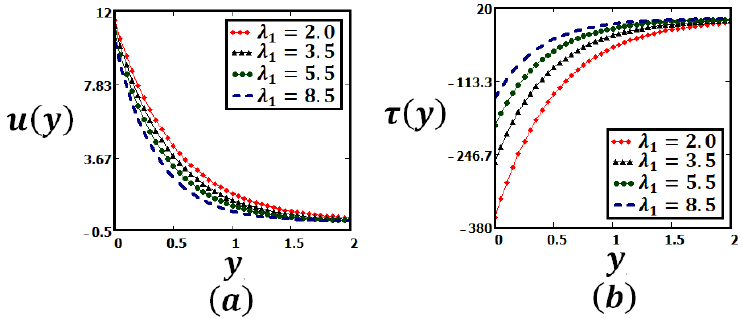
Figure 3: Profiles of the velocity field u ( y , t ) and the shear stress τ ( y , t ) for fractionalized Jeffrey fluid given by Eqs. (16) and (21), for A = 1, ν = 1.427, µ = 19, λ 2 = 2, H = 0.5, K = 2, α = 0.5, θ = 0.2, p = 4, t = 2 s and different values of λ 1